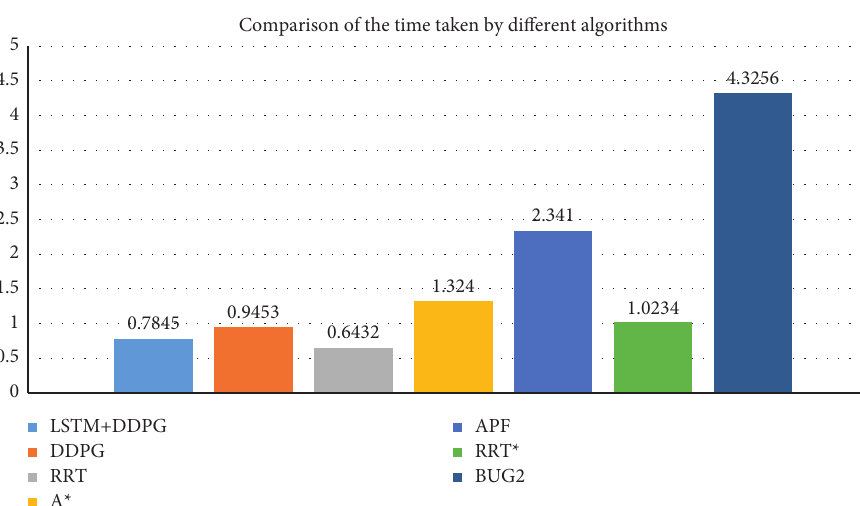
Figure 15: Comparison of the time taken by different algorithms.